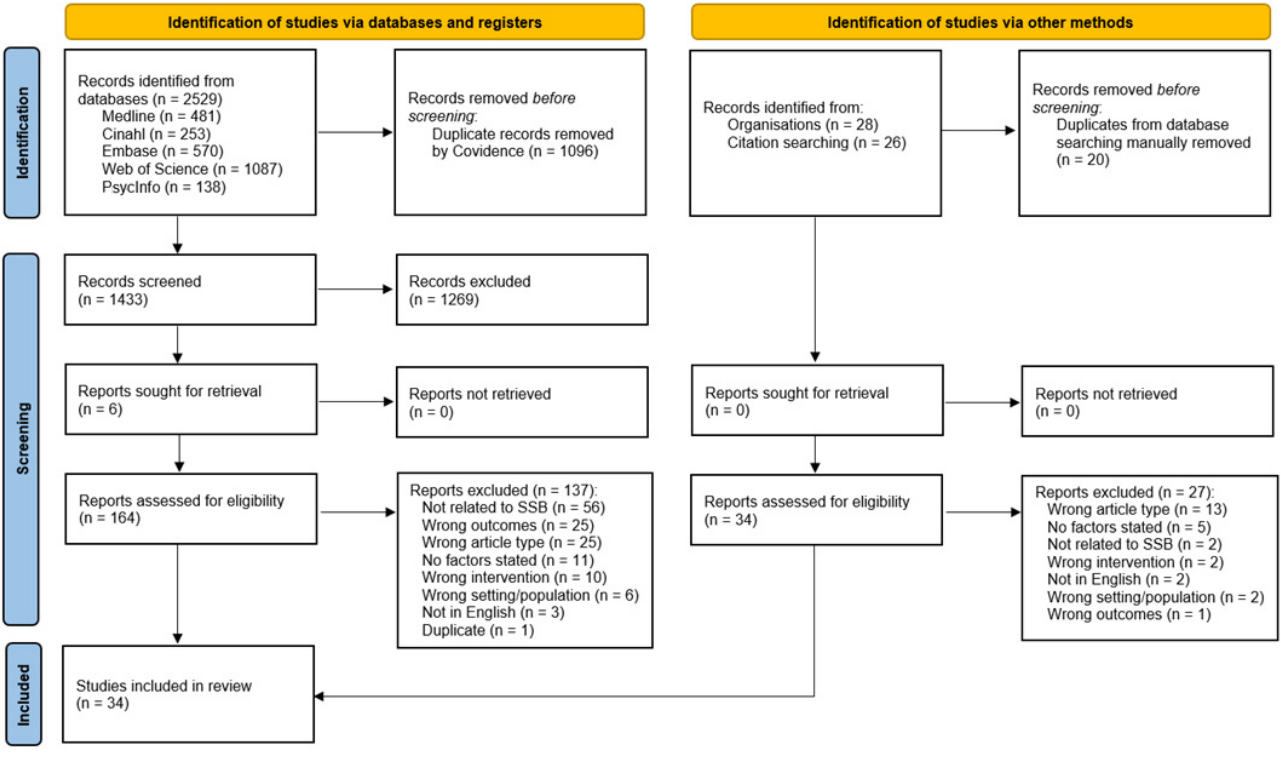
Figure 1. PRISMA flow diagram [29]. Table 2. MMAT quality assessment for included studies